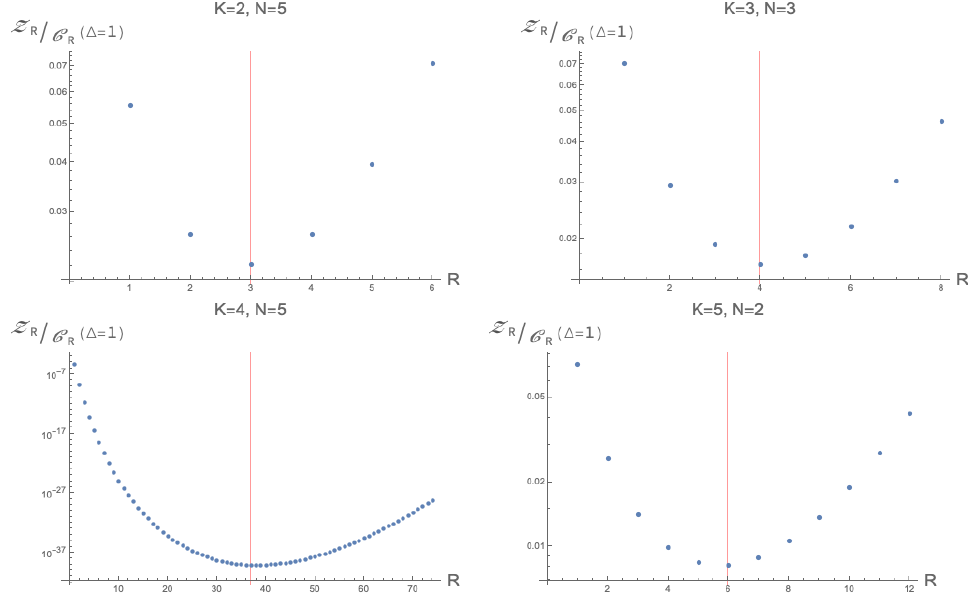
Figure 4. Examples of the minimums when choosing w to be (27). The horizontal axis labels R , while the vertical axis labels Z R / C R ( ∆ = 1 ) . The red line represents the expected rank, see (A2), of the tensor space (which is taken to be